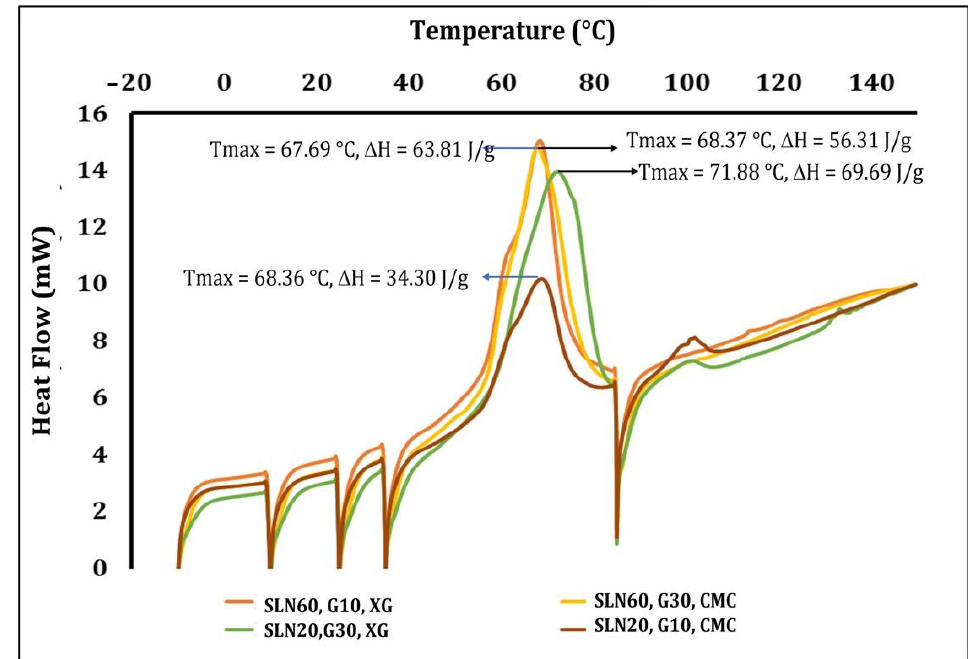
Figure 2. Thermal behavior of films with SLN added at different